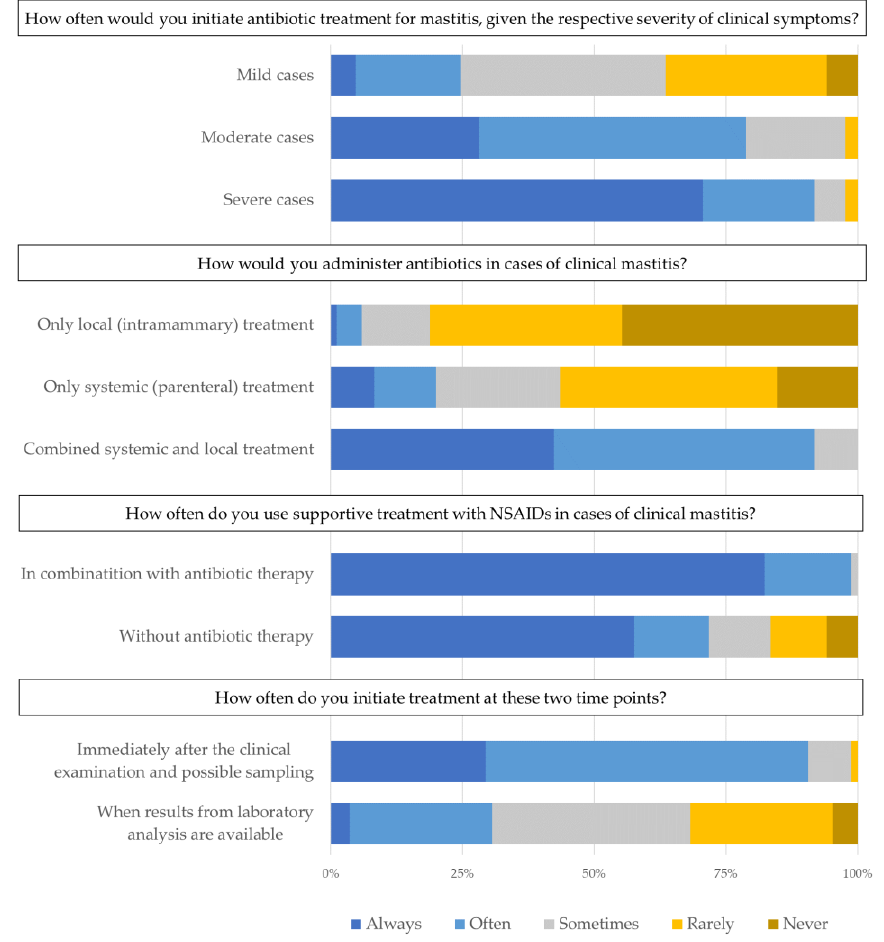
Figure 1. Answers from 85 Danish veterinarians to closed questions about treatment decisions in cases of clinical